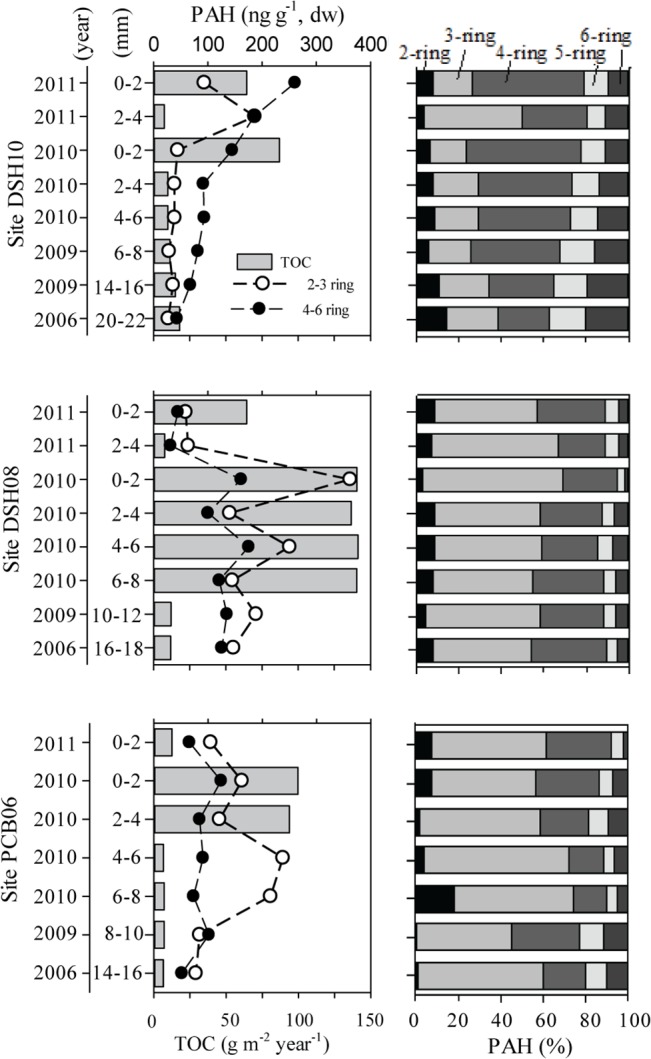
TOC rates, 2–3 ring (low molecular weight, LMW) and 4–6 ring (high molecular weight, HMW) PAH concentrations, and PAH composition profiles (2-, 3-, 4-, 5-, 6-ring) for each study site (DSH10, DSH08, PCB06).Data shown are for cores collected in 2010 (interval: 2010 to 2006) and 2011 (only 2011 data). 2-ring: Naphthalene and alkylated homologues; 3-ring: Acenaphthylene, Acenaphthene, Fluorene, Dibenzothiophene, Phenanthrene, Anthracene, and alkylated homologues; 4-ring: Fluoranthene, Pyrene, Benz[a]anthracene, Chrysene, and alkylated homologues; 5-ring: Benzo[b]fluoranthene, Benzo[k]fluoranthene, Benzo[a]pyrene, Dibenz[a,h]anthracene, and alkylated homologues; 6-ring: Indeno[1,2,3-cd]pyrene, Benzo[ghi]perylene.